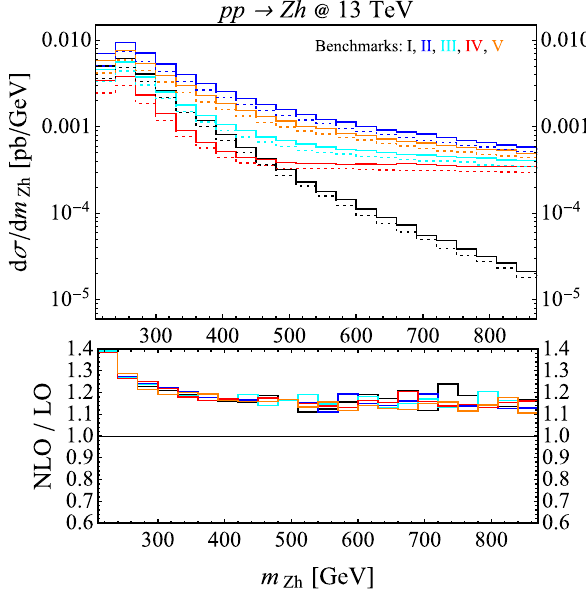
Fig. 1 Invariant mass distribution of the Z H system in pp → Z H